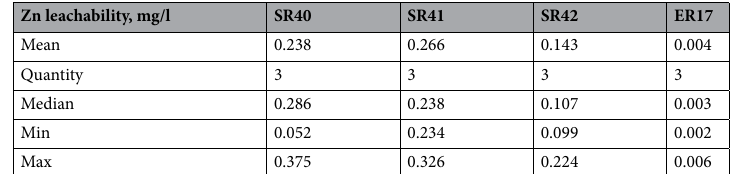
Zn leachability,